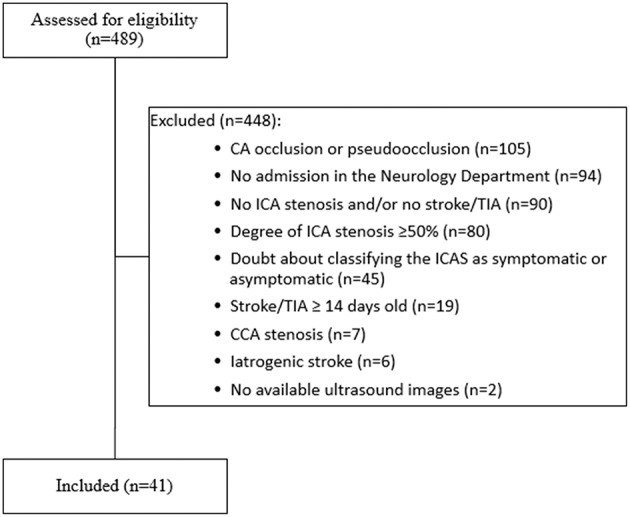
Flow chart showing the inclusion and exclusion criteria for patients enrolled in the present study. CA, carotid artery; CCA, common carotid artery; ICA, internal carotid artery; TIA, transient ischemic attack, iatrogenic stroke (5 cases after carotid endarterectomy, 1 case after coronary angiography). Of the 489 patients screened, only 41 patients met our inclusion and exclusion criteria.